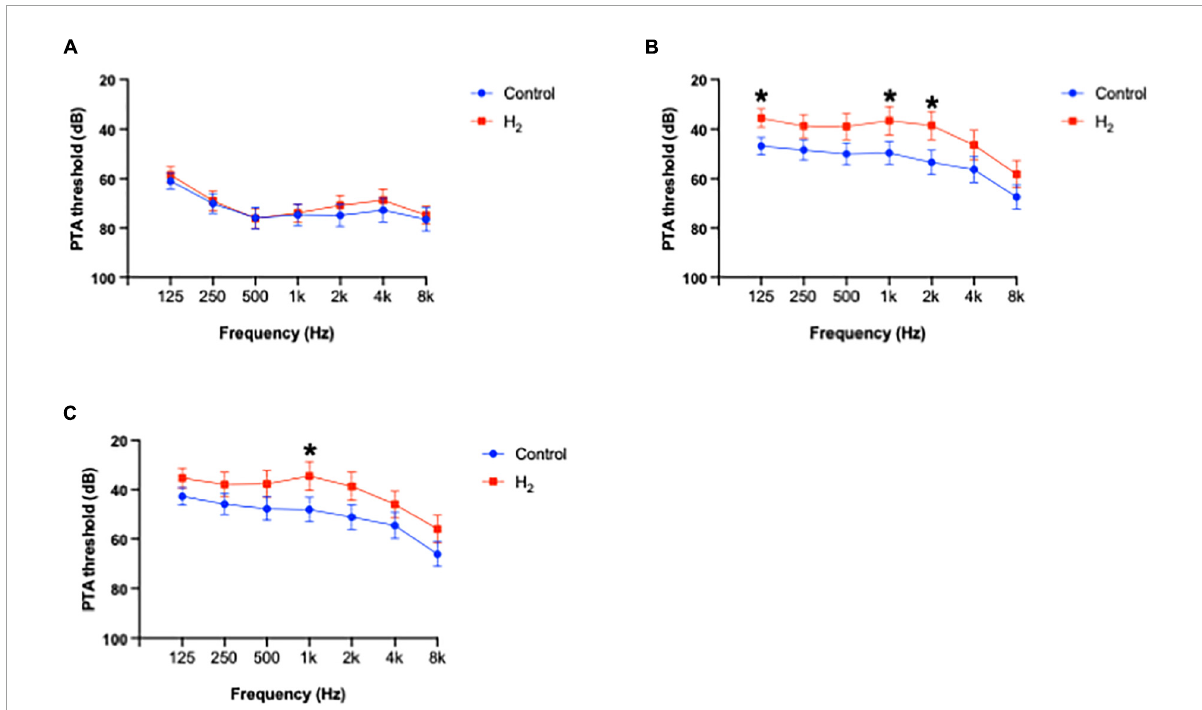
FIGURE9 Average of hearing threshold at each frequency. (A) PTA threshold at each frequency at initial visit. There were no significant differences between the groups. (B) PTA threshold at each frequency 1 month after treatment. The PTA thresholds at 125, 1 k, and 2 k Hz in the H 2 group were significantly better compared to those in the control group. * P < 0.05. (C) PTA threshold at each frequency 3 months after treatment. The PTA threshold 3 months after treatment at 1 k Hz was significantly better in the H 2 group than in the control group. * P <